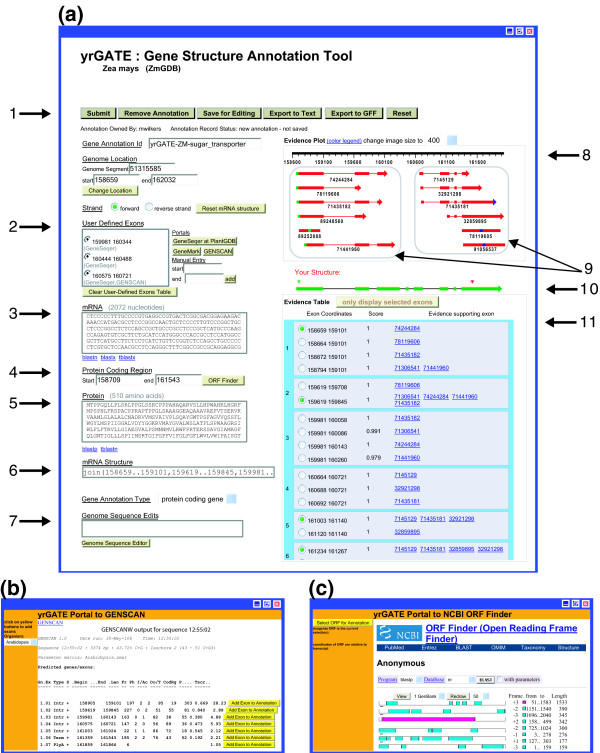
Novel gene annotation. This yrGATE implementation at ZmGDB presents the region 158659-162032 of Zea mays BAC gi 51315585. (a) The main Annotation Tool window contains a completed gene structure annotation. The provided transcript evidence consists of two groups of ESTs (9, circled) separated by a region with no spanning evidence, 160260-160664 (8). User defined exons have been designated in this region. The User Defined Exons Table (2) lists each exon by coordinates and source. (b) Exon 5, 160575..160721, was defined using portals to (b) GENSCAN and GeneSeqer@PlantGDB (not shown). Yellow buttons in the GENSCAN portal (b) add exons to the gene structure in the Annotation Tool (6 in panel a), which are presented pictorially (10 in panel a) for comparison with the Evidence Plot. A protein-coding region was evaluated using the portal to the (c) ORF Finder and imported into the Annotation Tool (4 in panel a) using the yellow button.